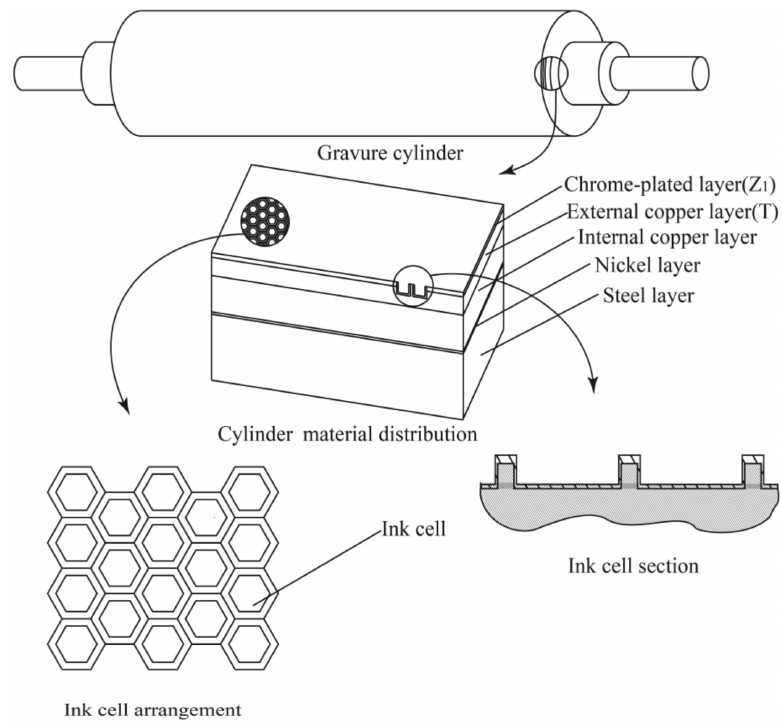
Figure 2. Multi-level description diagram of gravure printing plate